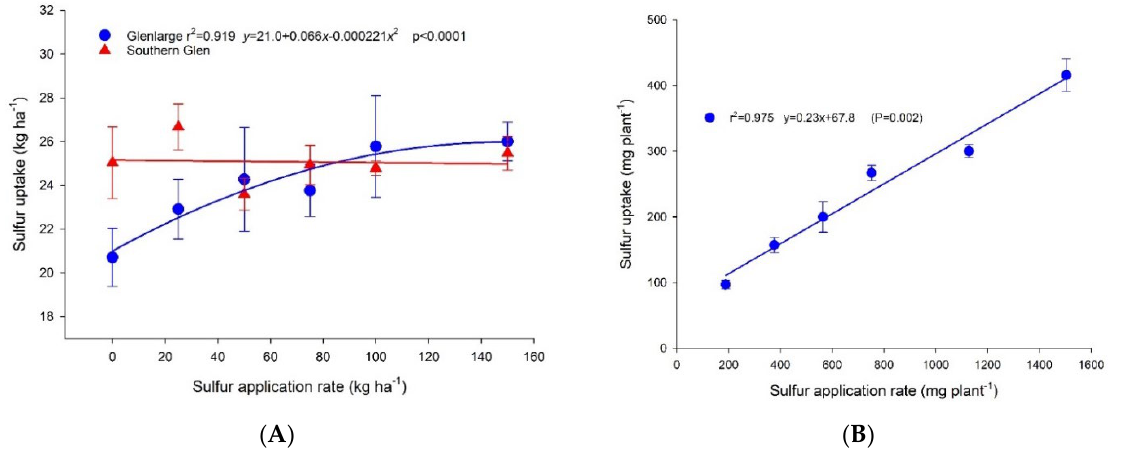
Figure 2. Sulfur uptake for cultivars Glenlarge (blue lines and symbols) and Southern Glen (red lines and symbols) grown in the field ( A ) and cultivar Glenlarge grown in solution culture ( B ). Values are means of 4 replicates with standard error bars shown if not obscured by the symbols.